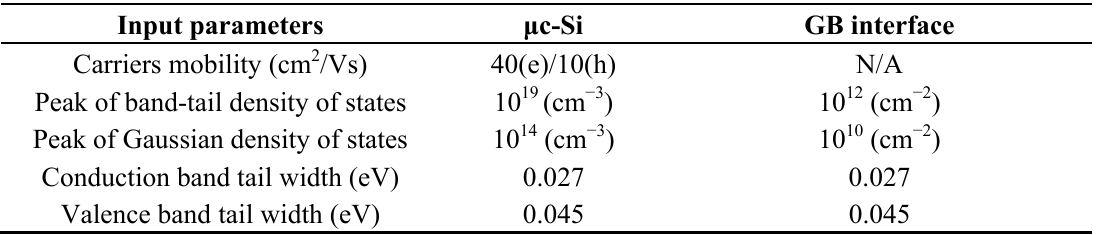
Table 1. Parameters used for microcrystalline silicon solar cells in this numerical study.